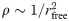
Equilibrium membrane displacement as a function of active force.(A) For various surface densities of non-specific adhesion molecules ρ, which relates to the free radius near the receptor rfree by ρ∼1/rfree2. (B) For various values of membrane tension σ0, applied at the boundary of both cells. Note since these data are at equilibrium, there is no thin-layer effect, and membrane separation is far-field separation minus membrane displacement. Further, since there is still nonzero separation from the second membrane, the presence of the second membrane does not influence the results. Thermal fluctuations are omitted throughout this figure.